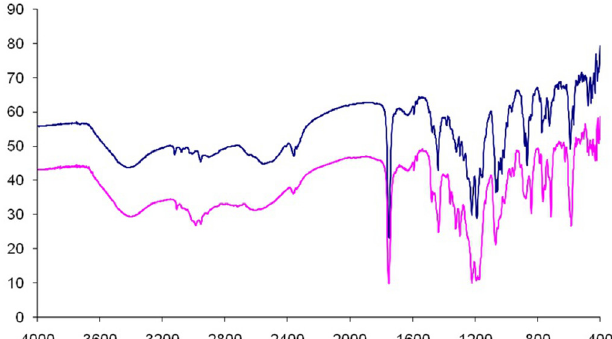
FIGURE 5 – Infrared spectra of clopidogrel bisulfate form I (bottom) and form II